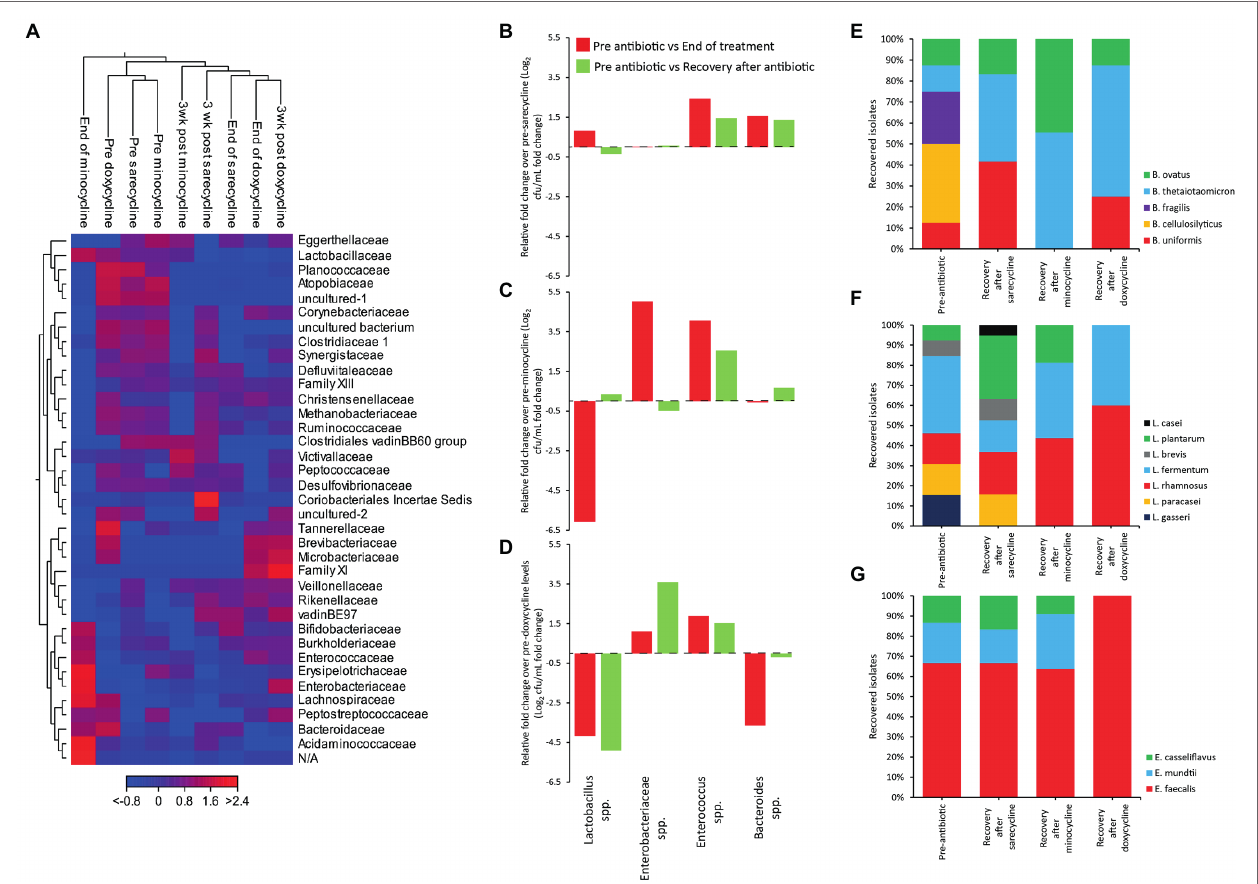
FIGURE 5 | Comparative analysis of the effect of antibiotics on the human microbiota. Heat map comparing the microbial abundance before antibiotic administration, at the end of antibiotic, and at the end of the recovery phase (A) . Fold change in bacterial recoveries at the end of antibiotics (red bars) and at the end of recovery phase (green bars) compared with pre-antibiotic levels, for sarecycline (B) , minocycline (C) , and doxycycline (D) . Fold change levels calculated from microbial enumeration on selective agars shown in Supplementary Figure S2 . Bacteroides (E) , Lactobacillus (F) , and Enterococcus (G) species diversity from selective agar plates before antibiotics and at the end of recovery phase. Approximately 20 colonies from each agar type, for each model, at each time point were identified by